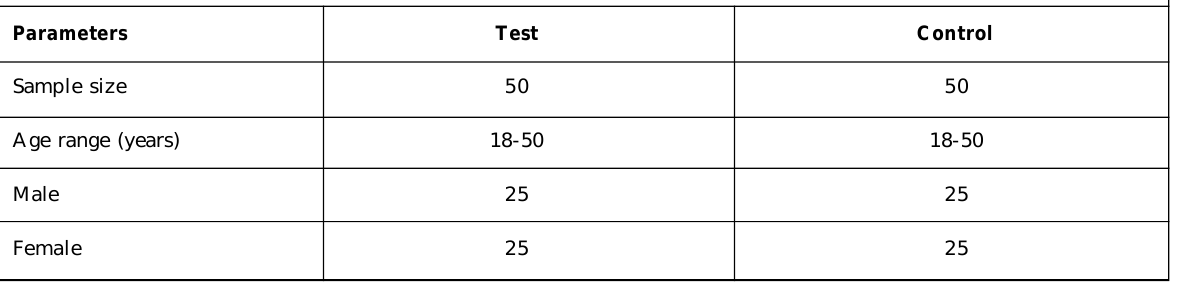
Table 2: The result of the measured biochemical parameters Serum